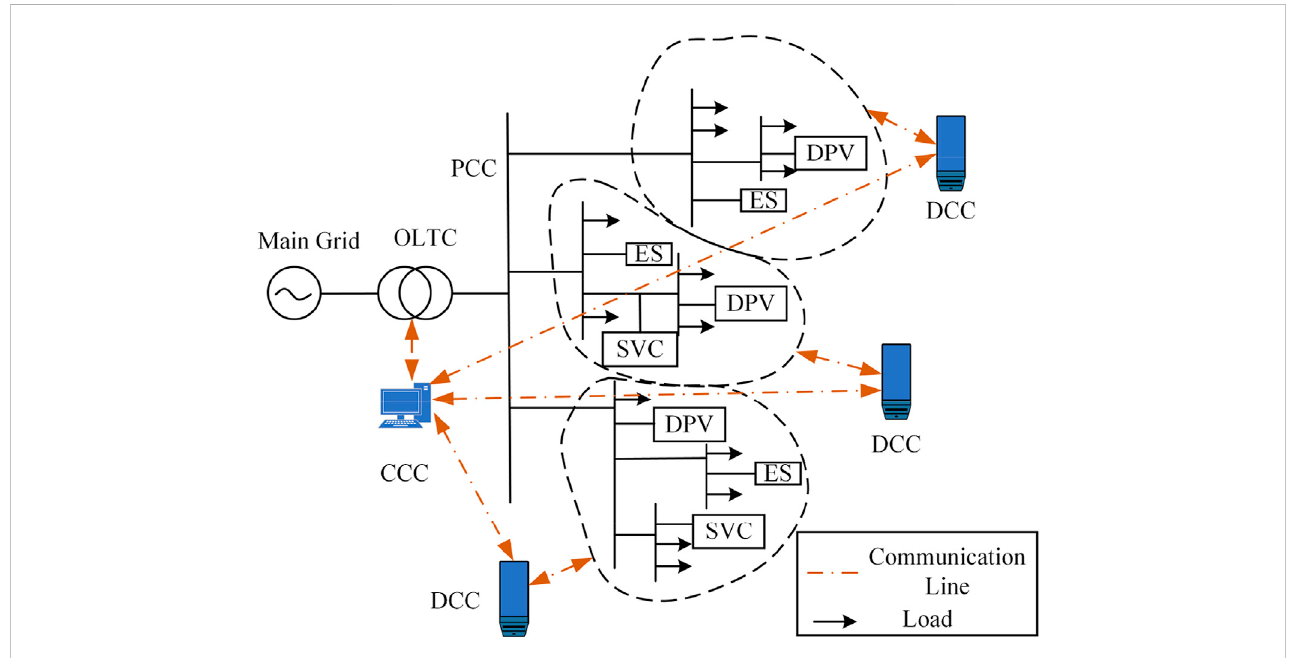
FIGURE 1 Connection diagram of the proposed control